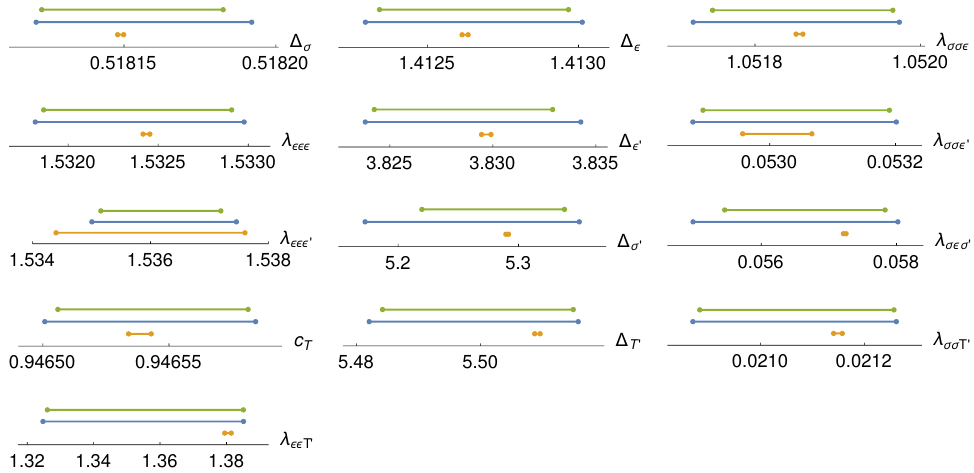
Figure 3 . Bounds on the OPE data for operators with a dimension below 6 for the sectors studied in this paper. In blue: rigorous bounds found at Λ = 19 by demanding a sparseness assumption of the form ∆ 6 in one sector at a time. In green: the allowed interval found using the 13 O 00 > parameter navigator function at Λ = 19 using a sparseness assumption of the form ∆ sectors at once. The combined sparseness assumptions (only) slightly reduce the size of the allowed intervals. The one-standard-deviation interval found using the EFM method at Λ = 43 is included in orange for